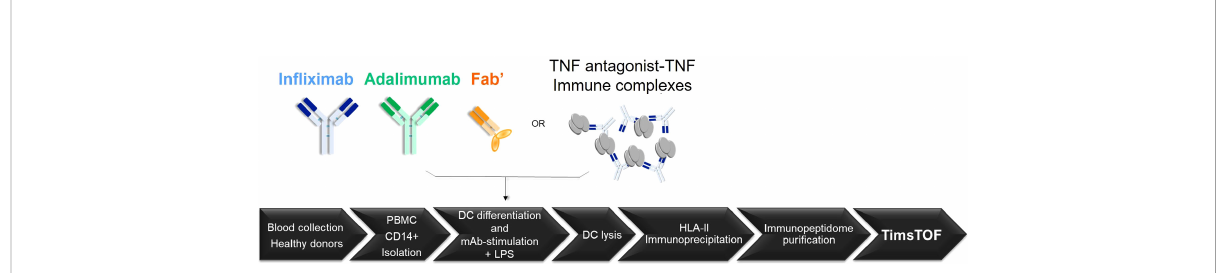
FIGURE 1 HLAII immunopeptidomics work fl ow for the identi fi cation of peptides presented from TNF antagonists by DCs. Freshly isolated PBMCs collected from fourteen healthy donors were isolated by density separation for subsequent CD14+ monocyte-puri fi cation. CD14+ monocytes were cultured and differentiated into DCs for six days. DCs were loaded with TNF antagonists or their preformed TNF immune complexes at day 5, followed by LPS stimulation for 22 h. DCs were harvested, washed and lysed to obtain whole protein extracts for HLAII immunoprecipitation using a pan-HLAII antibody. The HLAII immunopeptidome was puri fi ed by fi ltration and by C18 prior to LC-MS/MS analysis using trapped ion mobility time-of- fl ight mass spectrometry (timsTOF